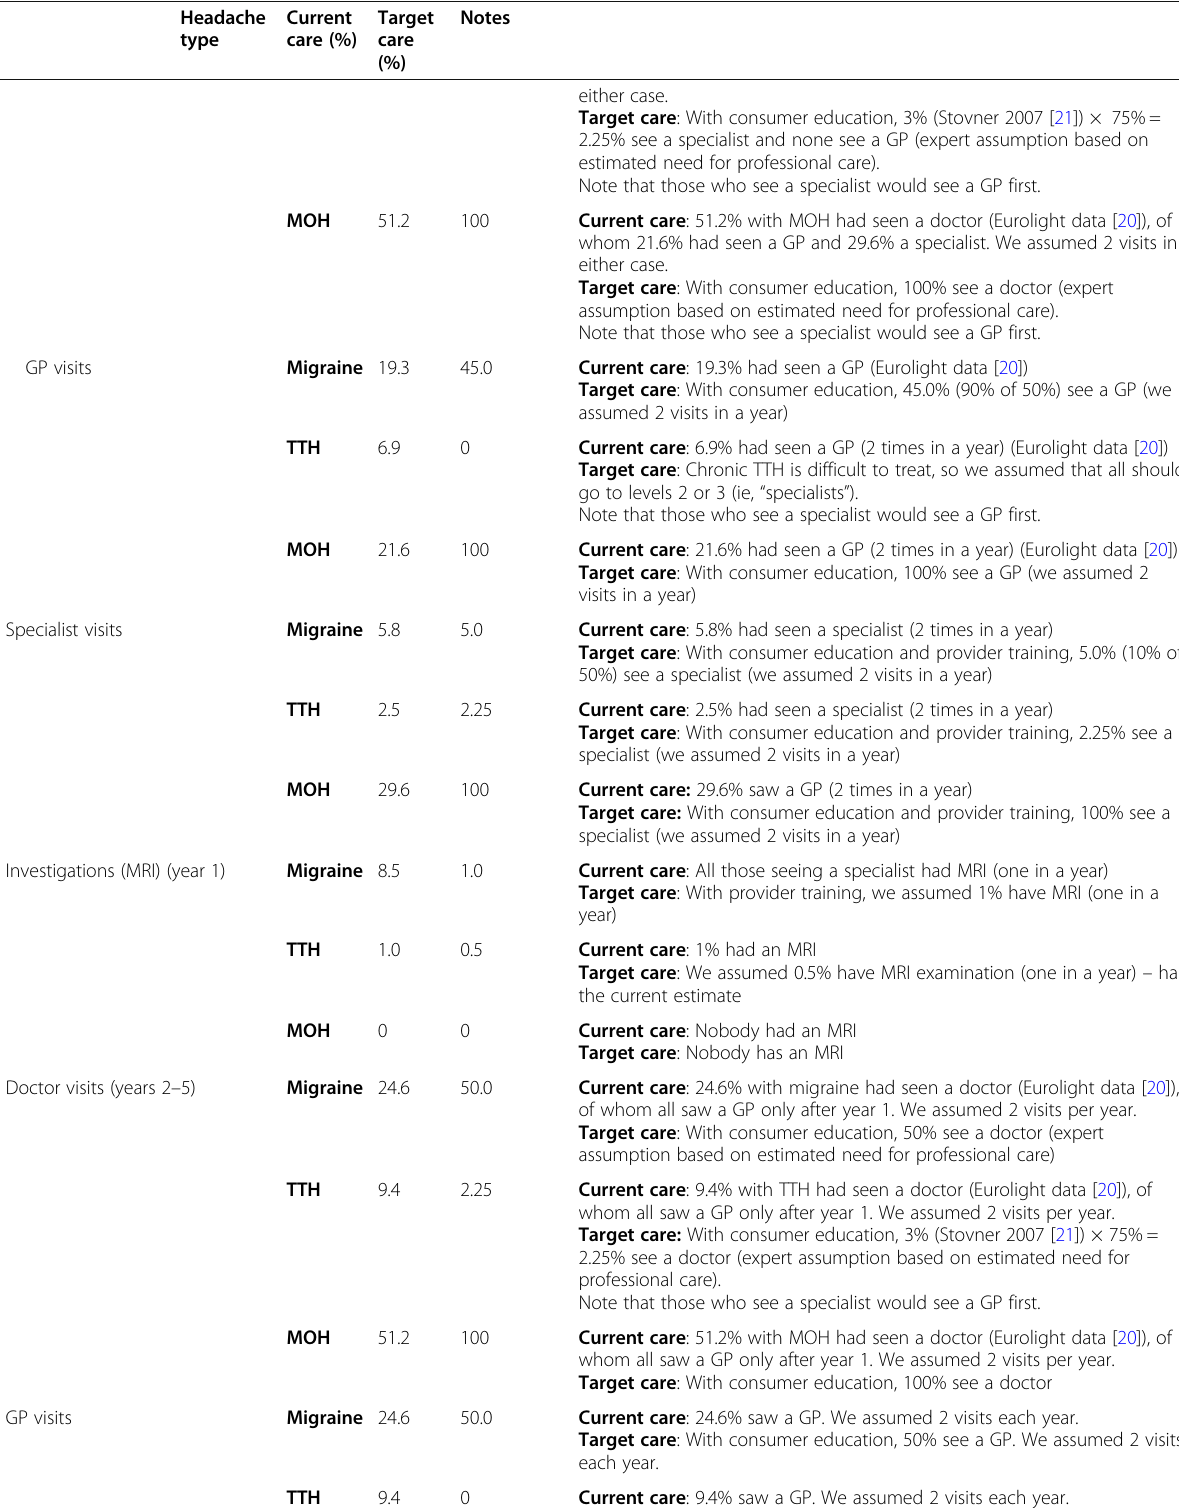
Table 1 Treatment uptake, use of resources and lost productivity according to treatment management plan (Luxembourg)